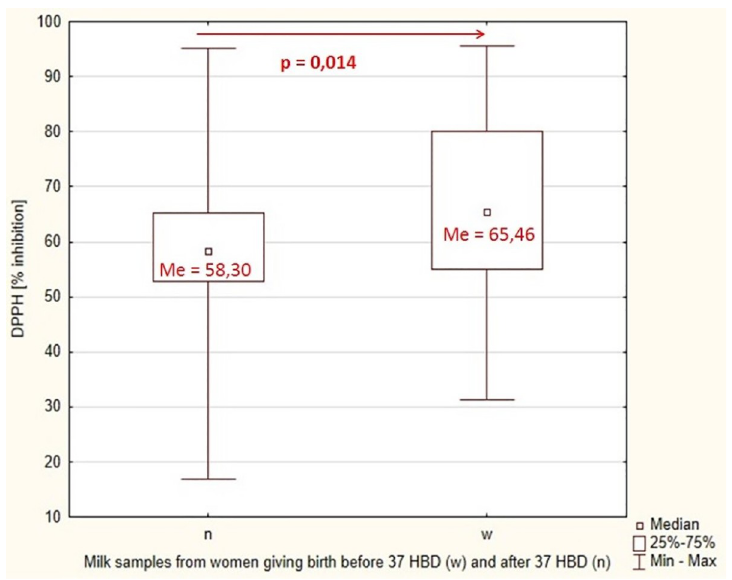
Fig 3. Statistical significance of differences in % DPPH inhibition in breast milk between the group of women giving birth before 37 weeks of pregnancy and the group of women giving birth after 37 weeks of pregnancy.